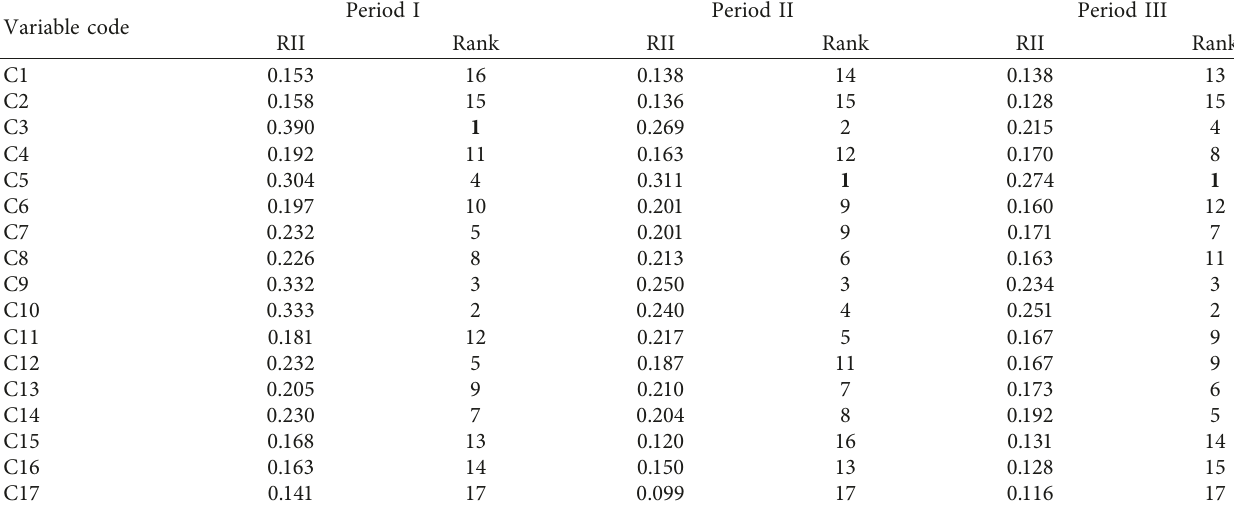
Table 14: Result of the risk importance index (RII) for equipment factor.